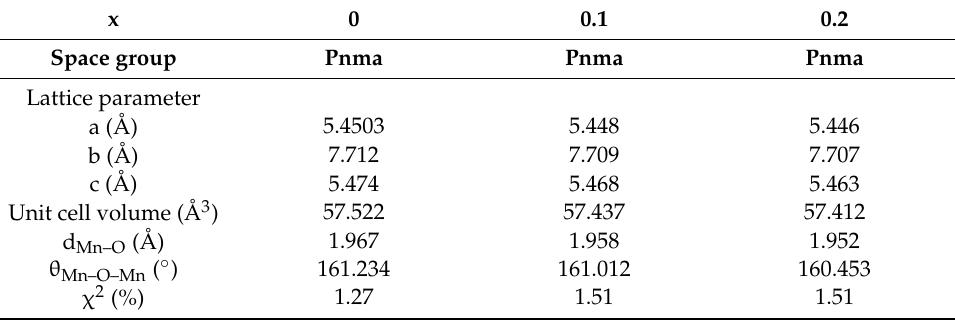
Table 1. Results of Rietveld refinements, determined from XRD patterns recorded at room temperature for La 0.8 − x (cid:3) x Ca 0.2 MnO 3 ( x = 0, 0.1 and 0.2) compounds annealed at 973 K